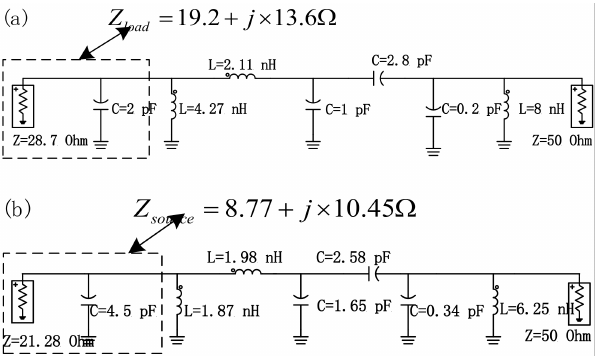
Figure 7. The structure of matching networks. ( a ) output matching network; ( b ) input matching network.